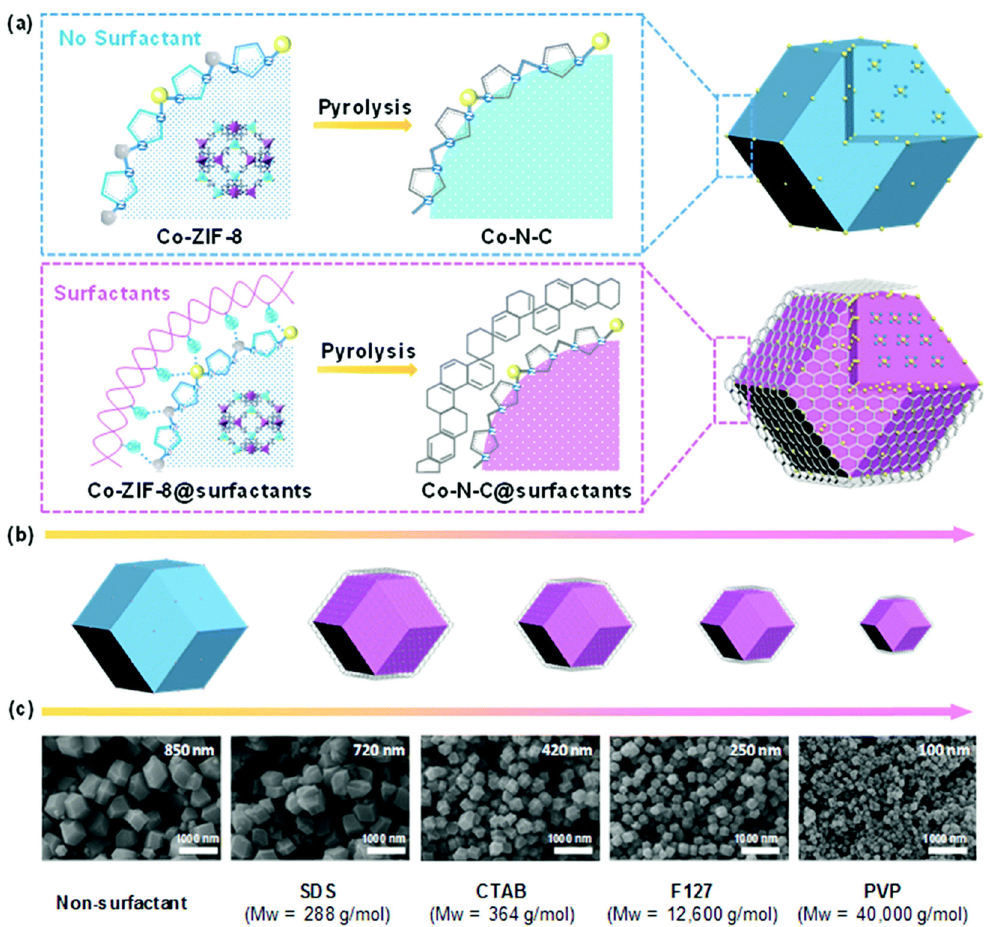
Figure 9. ( a ) In situ confinement pyrolysis strategy used to synthesize core–shell-structured Co-N-C@surfactant catalysts with increased active site density. ( b ) Expected particle sizes and ( c ) SEM images showing the different morphologies and particles sizes of catalysts obtained in the presence and absence of surfactants (SDS, cetrimonium bromide (CTAB), F127, and polyvinylpyrrolidone (PVP)). Reprinted with permission from ref. [96]. Copyright (2018) Royal Society of Chemistry.